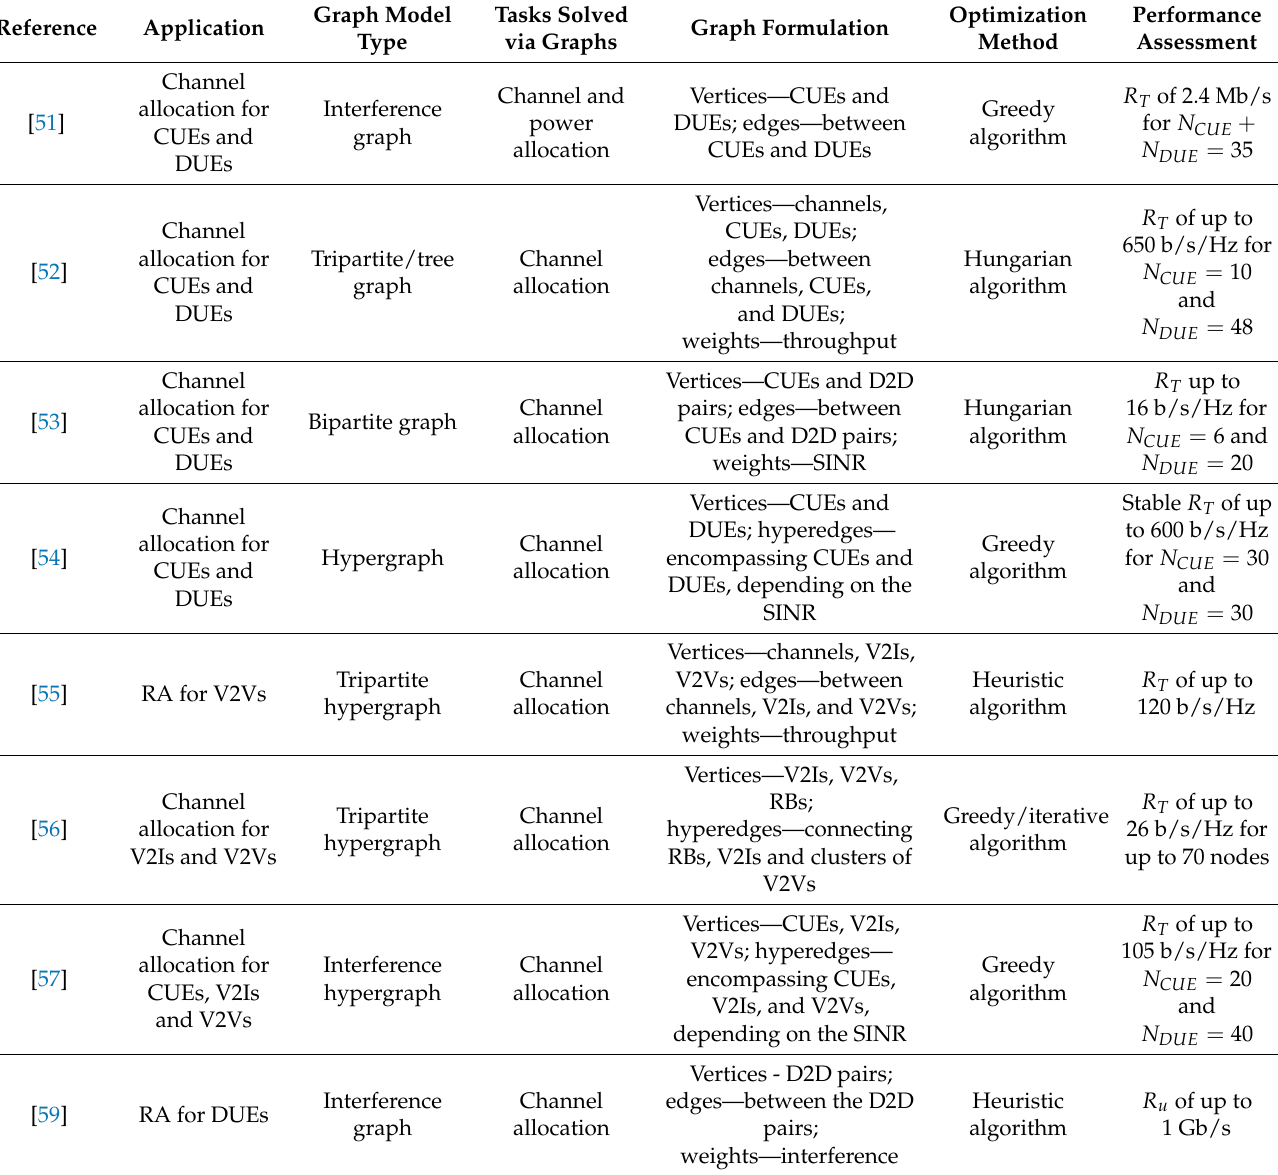
Table 7. Tabular summary for graph-based RA in D2D